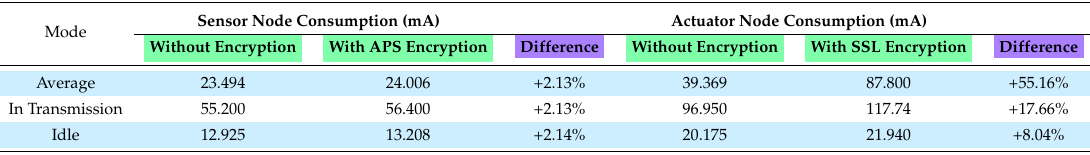
Table 10. Node consumption with and without